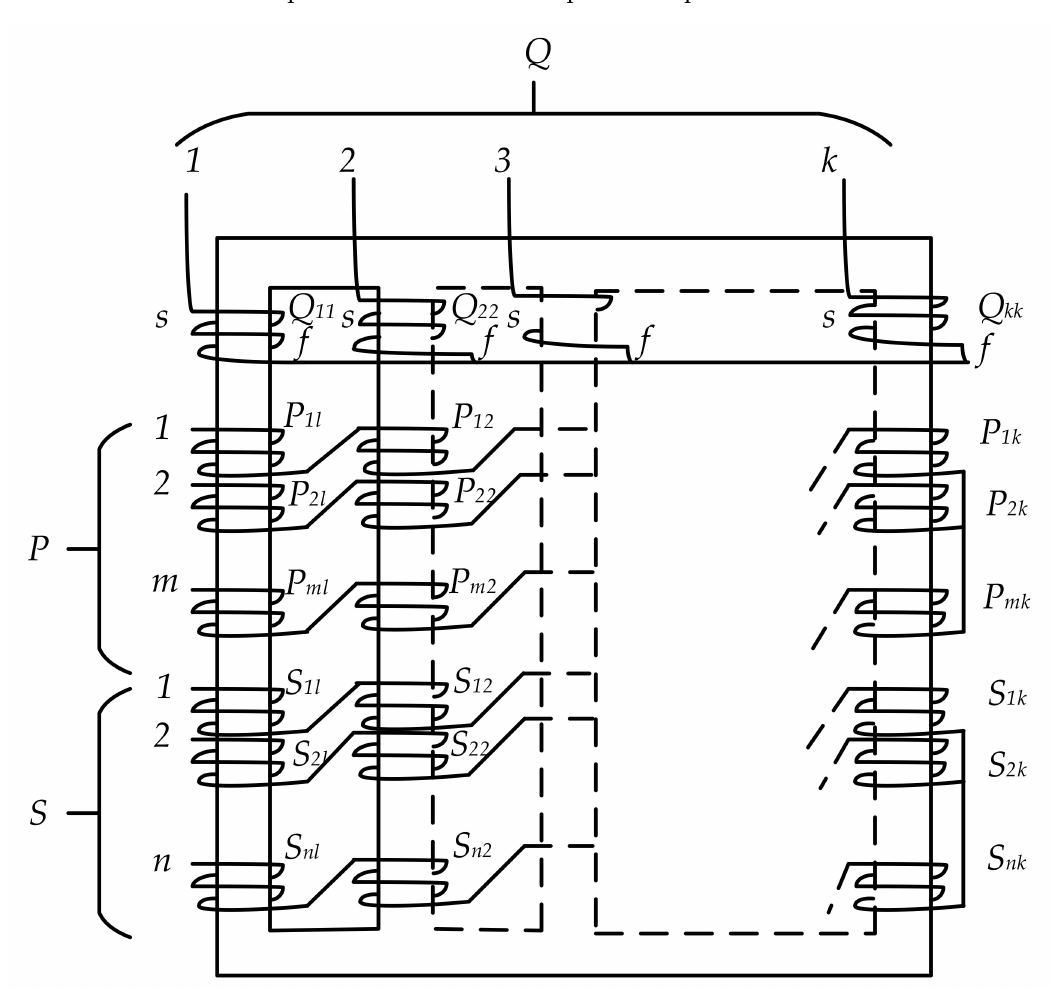
Figure 1. A basic k-limbed multi-phase